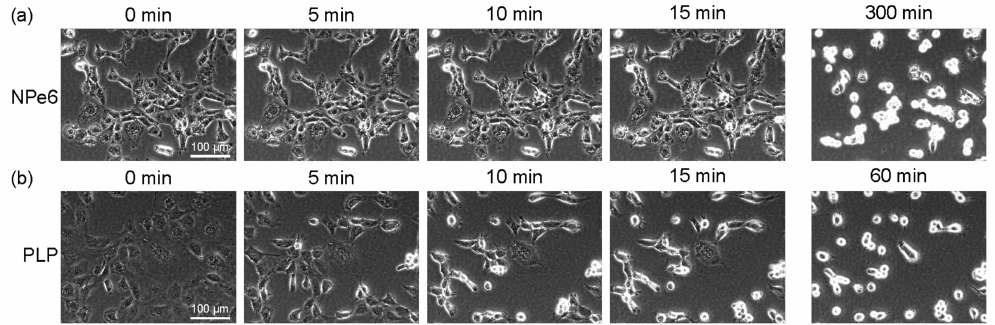
Figure 2. Time-lapse phase-contrast images of RGK1, which had been left standing in an incubator for 24 h after adding NPe6 ( a ) or PLP ( b ), then irradiated with light of 34 mW/cm 2 at a wavelength of 655 nm for 1